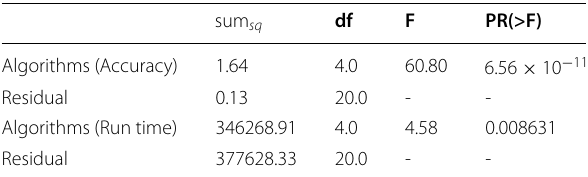
Table 7 ANOVA test result of accuracy and run time among five